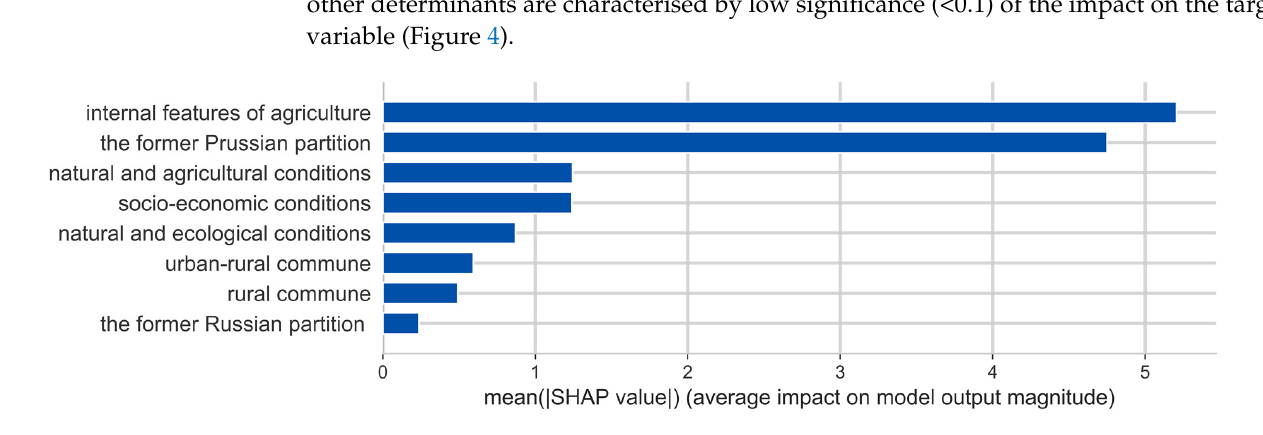
Figure 4. Significance of determinants received from the correction of the node clarity. Source: developed by the authors, based on ARMA and CSO data.